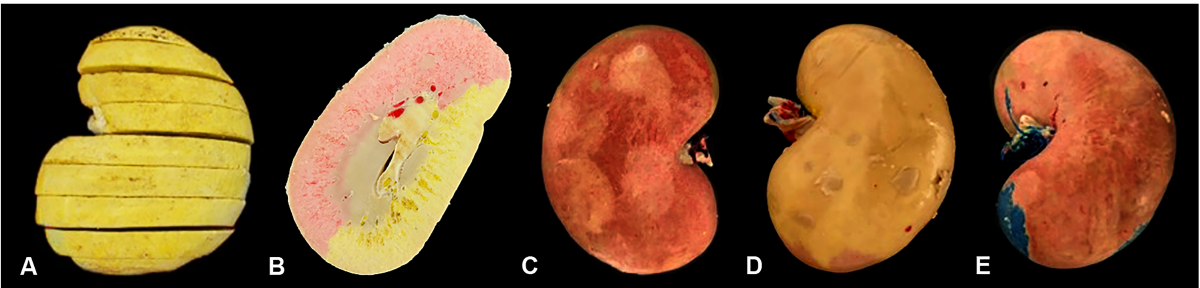
Figure 1 - Ovine kidney prepared for proportional volume analysis of each segment. At image A, after resin injection of different colors into each segmental artery, the kidney was sectioned in 0.5-thick slices. At image B it is noted the surface of one transverse section, with the region irrigated by ventral (red) segmental artery and dorsal (yellow) segmental artery. Ventral (C) and dorsal (D) faces of two-segment ovine kidney, and ventral face of three-segment ovine kidney (E) after resin injection of different colors into each segmental